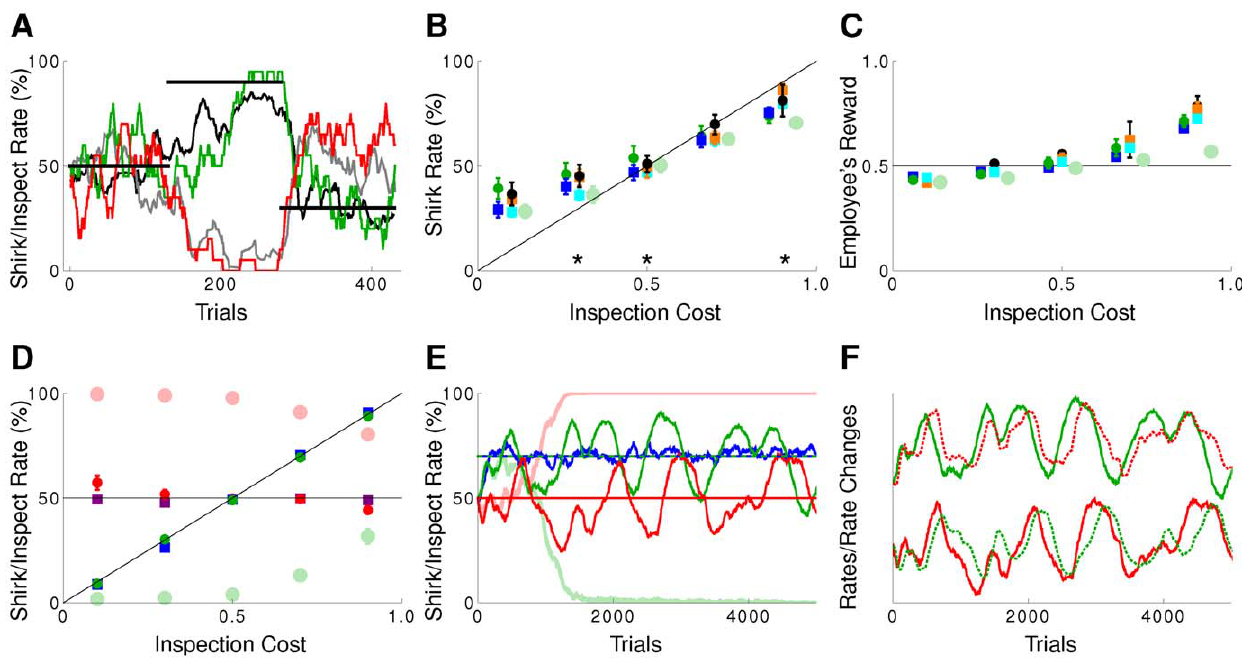
Figure 3. pRL but not TD-learning fits data and follows a mixed Nash equilibrium. (A) Choice behavior for pRL versus pRL (employee green, employer red) and human versus human (employee black, employer gray) [11]. The cost of inspection was stepped from 0 : 5 to 0 : 9 to 0 : 3 , respectively, and this does also correspond to the shirk rate in Nash equilibrium (thick black lines). The inspection rate in the Nash equilibrium would always be 0 : 5 . (B) Average choice behavior of pRL vs pRL (dark green circles) and TD vs TD (light green circles), pRL for the employee vs computer algorithm for the employer (blue squares), human vs human (black), human as an employee vs computer algorithm (orange) and monkey vs computer algorithm (cyan) for 150 trials/block as function of the inspection cost. The solid line indicates the Nash equilibrium. (C) Reward as function of the inspection cost for 150 trials/block. Coloring as in (B). pRL simulations are more similar to the experimental data than the TD simulations. (D) Average choice behavior as in (B) but for 5000 trials/block. The inspect rates for pRL vs pRL (TD vs TD) (dark (light) red circles) and pRL vs computer algorithm (purple squares) are shown too. The lines indicate the Nash equilibrium for the employee (diagonal) and the employer (horizontal). pRL behaves according to the Nash equilibrium, whereas TD does not. (E) Time course of the probability to shirk with inspection cost i ~ 0 : 7 for pRL vs algorithm (blue line) and pRL vs pRL (TD vs TD) (dark (light) green line). For the latter the probability of the employer to inspect is shown too (dark (light) red line). pRL oscillates around the Nash equilibrium (drawn lines), whereas TD completely deviates from Nash. (F) Time course of the probability to shirk or inspect respectively with inspection cost i ~ 0 : 7 for pRL vs pRL (green respectively red, solid) as in E, but shifted up for clarity and overlaid with the negative change in the shirk rate (green dashed) and the change in the inspect rate (red dashed) to show the counteractive behavior.